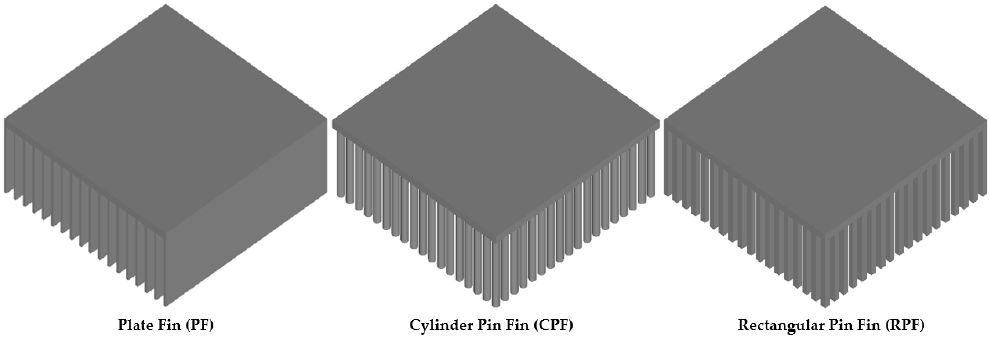
Figure 4. Schematics of three types of heat sinks with different fin structures. Table 2. Specifications of three types of heat sinks.